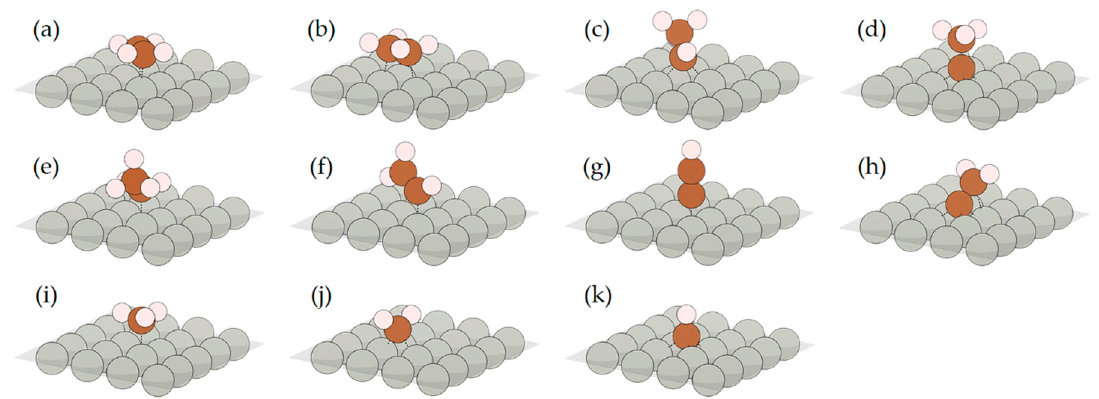
Figure 5. Visualization of the DFT-relaxed structures of different C n H m species on Pd (111) surface: π - ( a ) and di- σ -adsorbed ( b ) ethylene, ethylidene ( c ), ethylidyne ( d ), ethyl ( e ), μ -vinyl ( f ), ethynyl ( g ). vinylidene (h), methyl ( i ), methylene ( j ) and methine ( k ). For better visualization, only the top surface layer of palladium is shown.